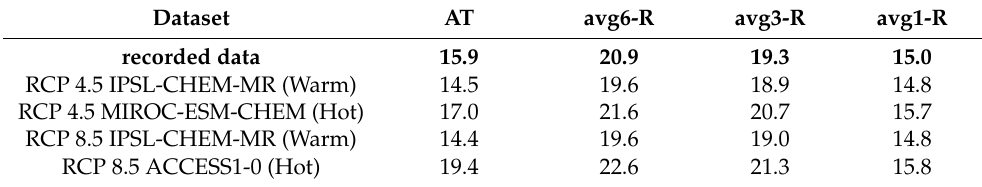
Table 12. Predicted average temperatures for 2012–2017, recorded water level. Dataset